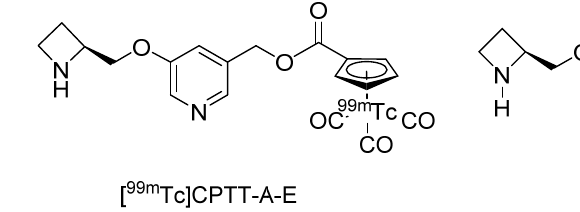
Figure 2. Representative α 4 β 2 nAChRs radioligands for SPECT.